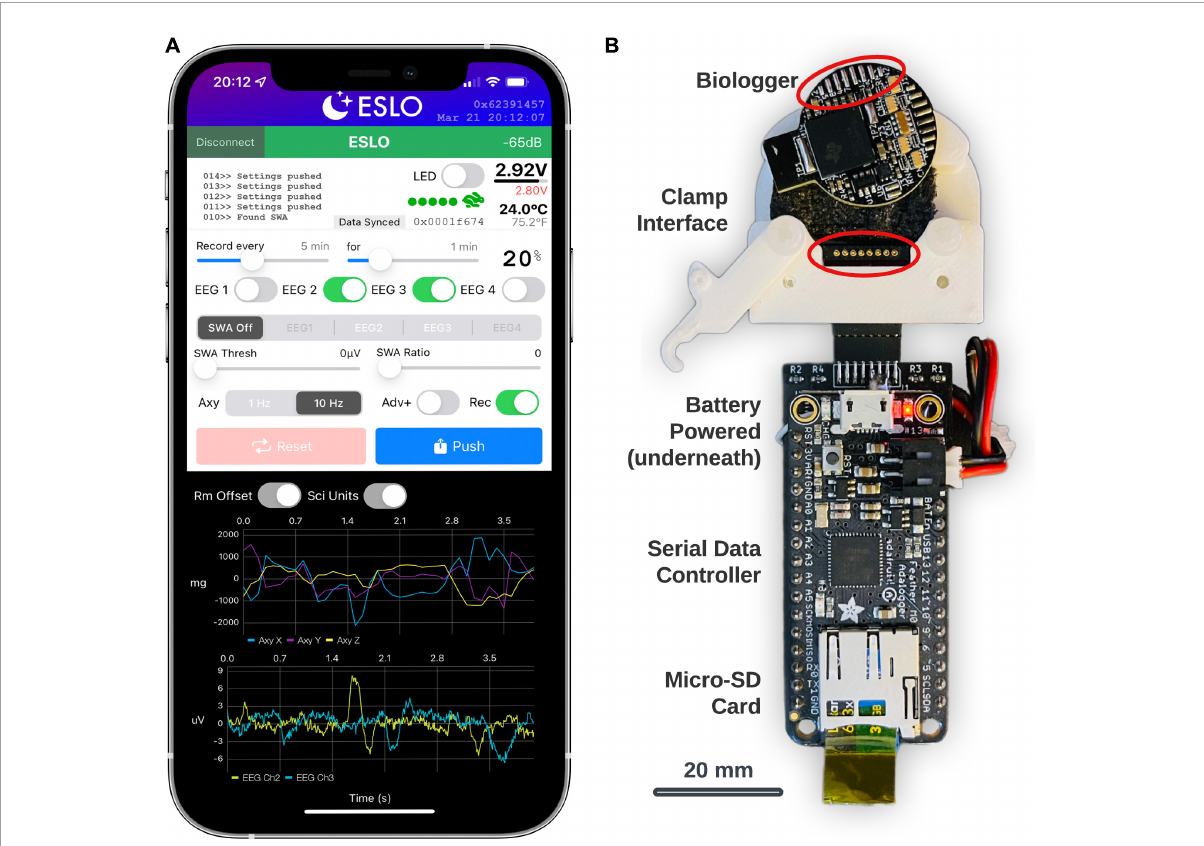
FIGURE3 Biologger iOS app configuration utility and data dump module. (A) The app is shown in a connected state with a biologger. These settings represent a recording schedule mode where two channels of biopotentials (EEG2 and EEG3) will record with a 20% duty cycle and accelerometer (Axy) data will record at 10 Hz. (B) The data dump module is shown below the biologger interface. The bottom of the biologger is displayed here to appreciate how the programming port pins interface with the pogo connector (circled in red) in the custom clamp module. Data from the biologger memory is transferred serially through the main data controller board on the micro-SD card.